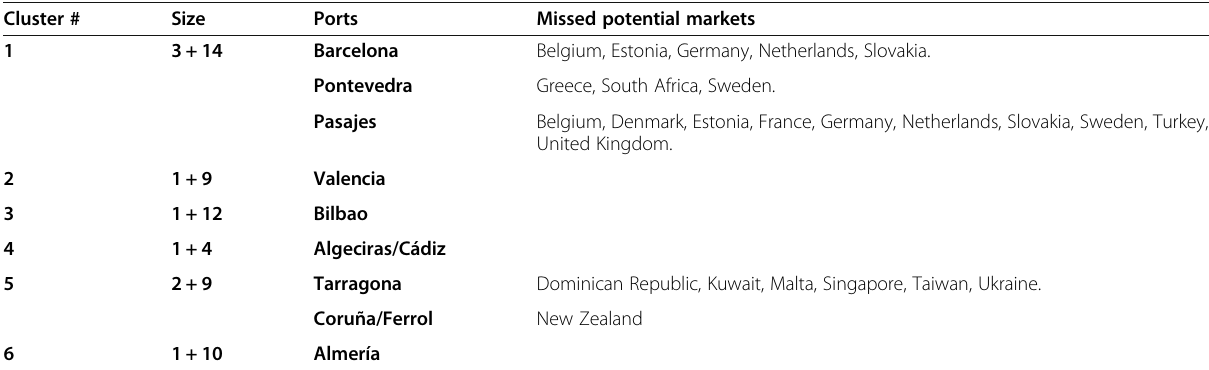
Table 4 Communities and link prediction for the “ Automobiles and their parts ” export graph, in 2019. Size means number of ports + number of countries in the community Cluster #